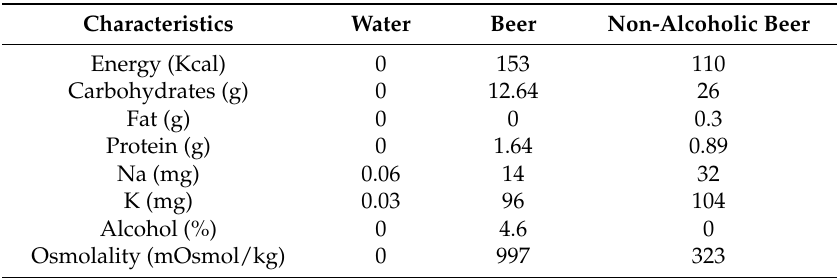
Table 2. Nutritional characteristics of drinks